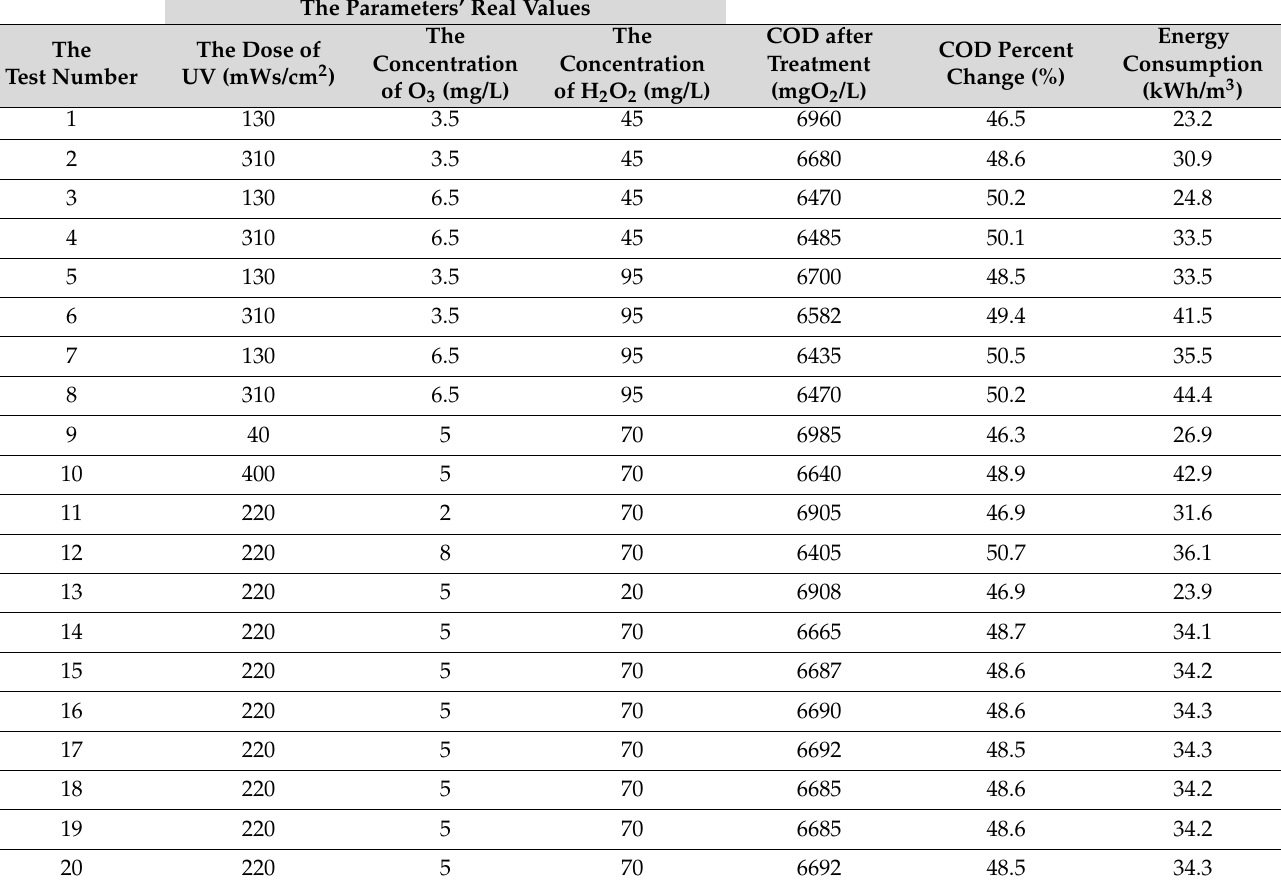
Table 3. Results of the 20 sets of